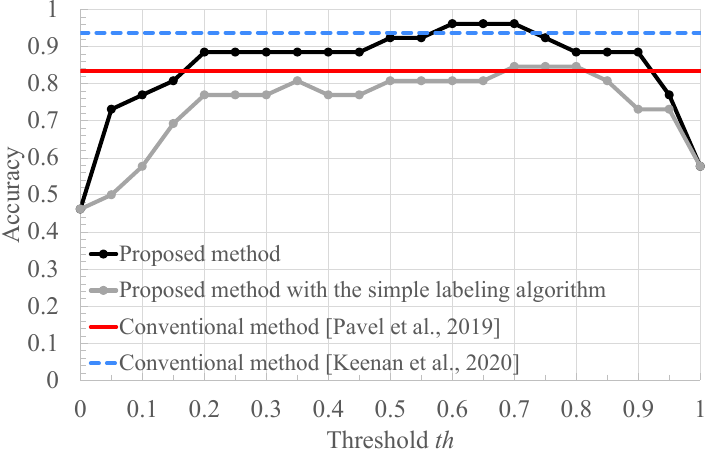
Figure 11. The accuracy of the conventional methods [8,9], the proposed method with the simple labeling algorithm, and the proposed